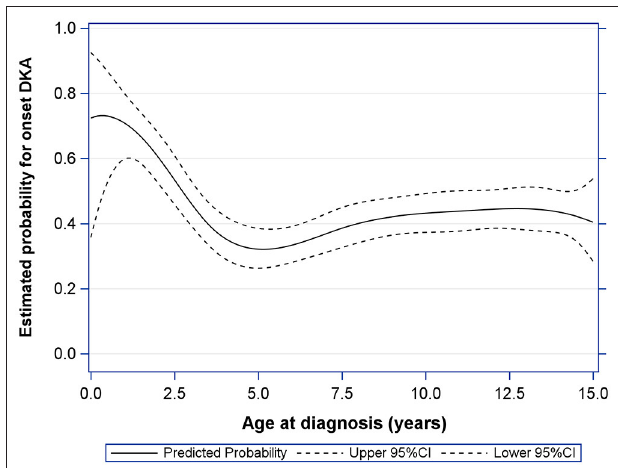
FIGURE 2 | Effect of age at diagnosis on estimated probability for DKA at T1D-onset (with upper and lower 95% confidence limit), adjusted for gender and year of diagnosis.